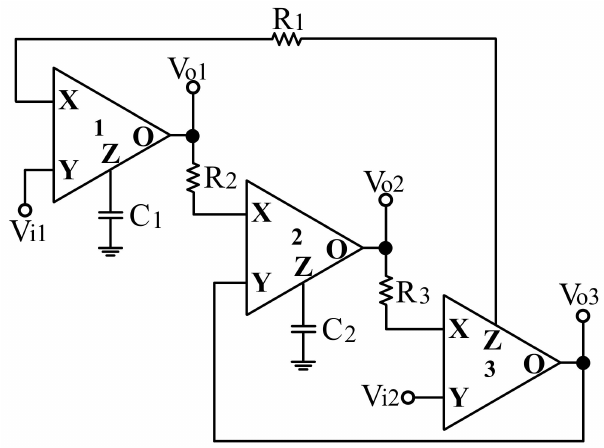
Figure 3. The proposed high-input impedance CFOA-based multifunction biquadratic